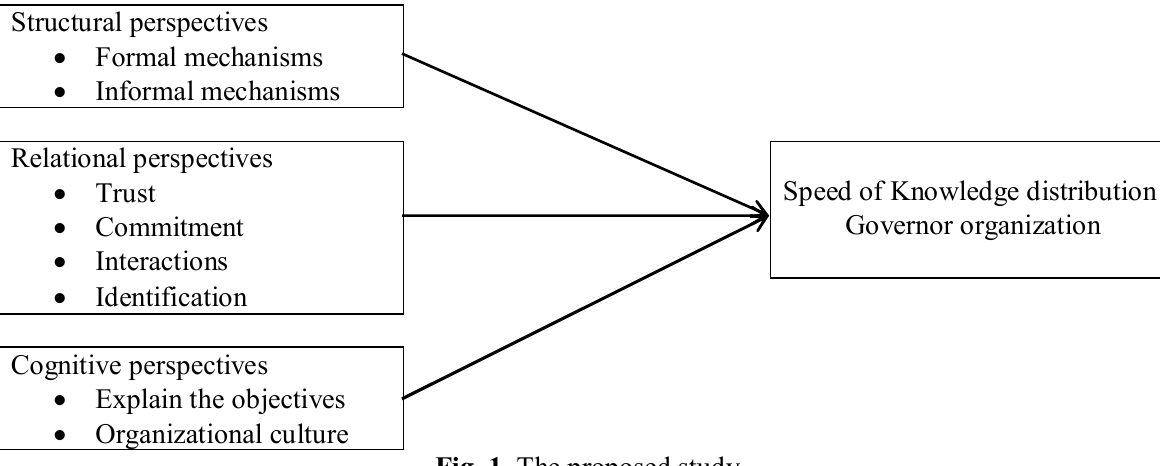
Fig. 1. The proposed